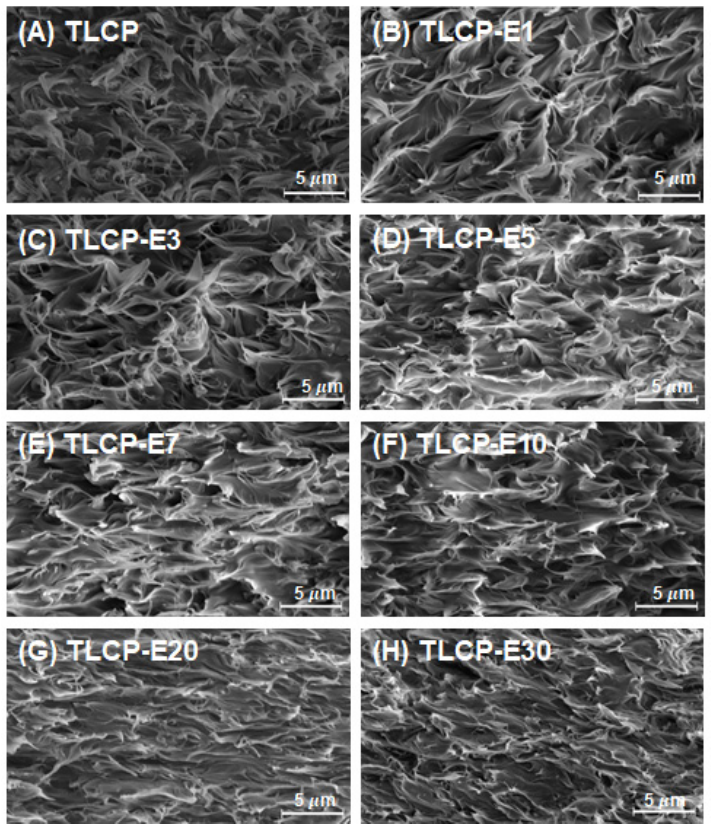
Figure 2. Cross-sectional scanning electron microscopy (SEM) images of neat TLCP and TLCP / PEGMA blends: ( A ) TLCP; ( B ) TLCP-E1; ( C ) TLCP-E3; ( D ) TLCP-E5; ( E ) TLCP-E7; ( F ) TLCP-E10; ( G ) TLCP-E20; ( H ) TLCP-E30. Table 1. Characteristic vibrational bands of neat TLCP, neat PEGMA, and TLCP / PEGMA blends in Fourier-transform infrared (FT-IR)